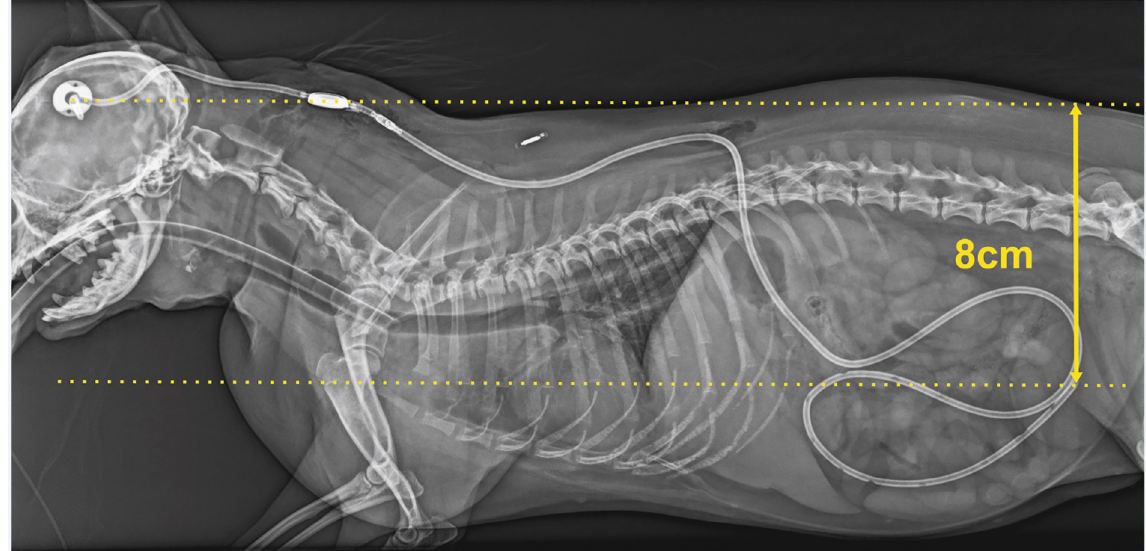
Fig 3. Postoperative latero-lateral radiograph after Ventriculo-peritoneal shunt implantantion of a Chihuahua (dog No. 11; Table 1). The dotted lines illustrate the distance between the ventricular catheter and tip of the peritoneal catheter.